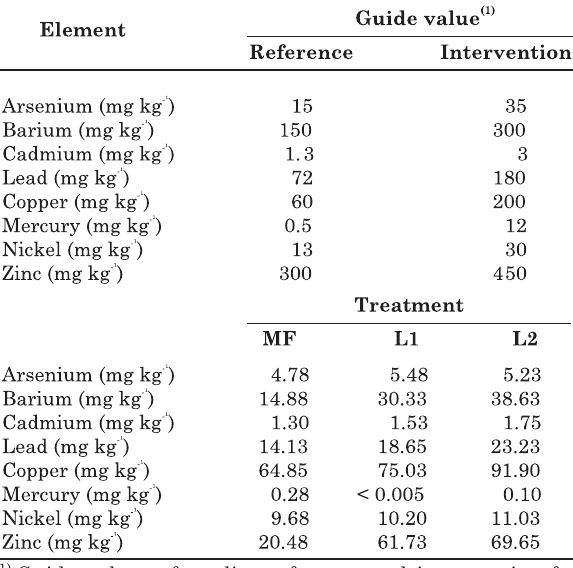
Table 6. Soil total concentrations of potentially toxic elements, at 0–0.20 m depth layer, from SS- treated plots (L1 and L2 sewage sludge rates) and MF-treated plots